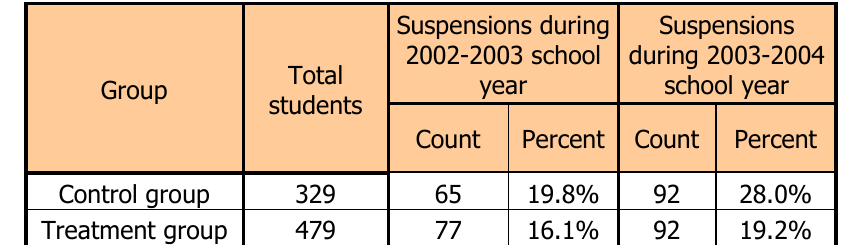
Number of Students Suspended in Control and Treatment